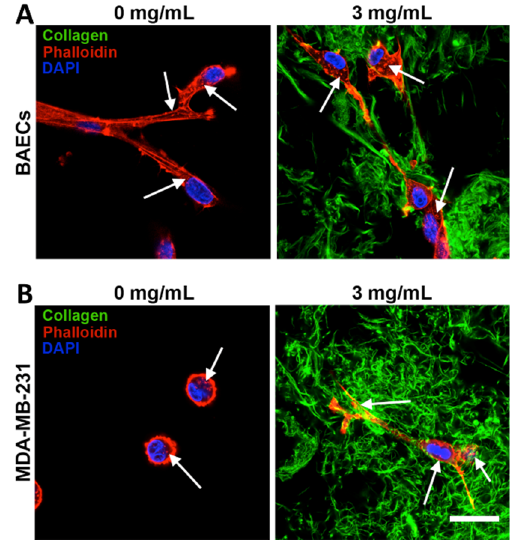
Figure 3. Effect of collagen fibers on single-cell morphology varies with cell type. ( A ) Bovine aortic endothelial cells (BAECs) exhibited a spread morphology in both the absence and presence of fibrillar collagen in 2 kPa GelMA/collagen gels, whereas ( B ) MDA-MB-231 cells remained rounded with no significant protrusions when fibrillar collagen was not present, but elongated and adopted a spread morphology when fibers were added to the 2 kPa scaffold. The inability to spread in the non-fibrillar scaffold prohibited the ability of the MDA-MB-231 cells to invade their surrounding matrix. White arrows point to actin staining puncta. Figure adapted from [112] and reprinted with permission.